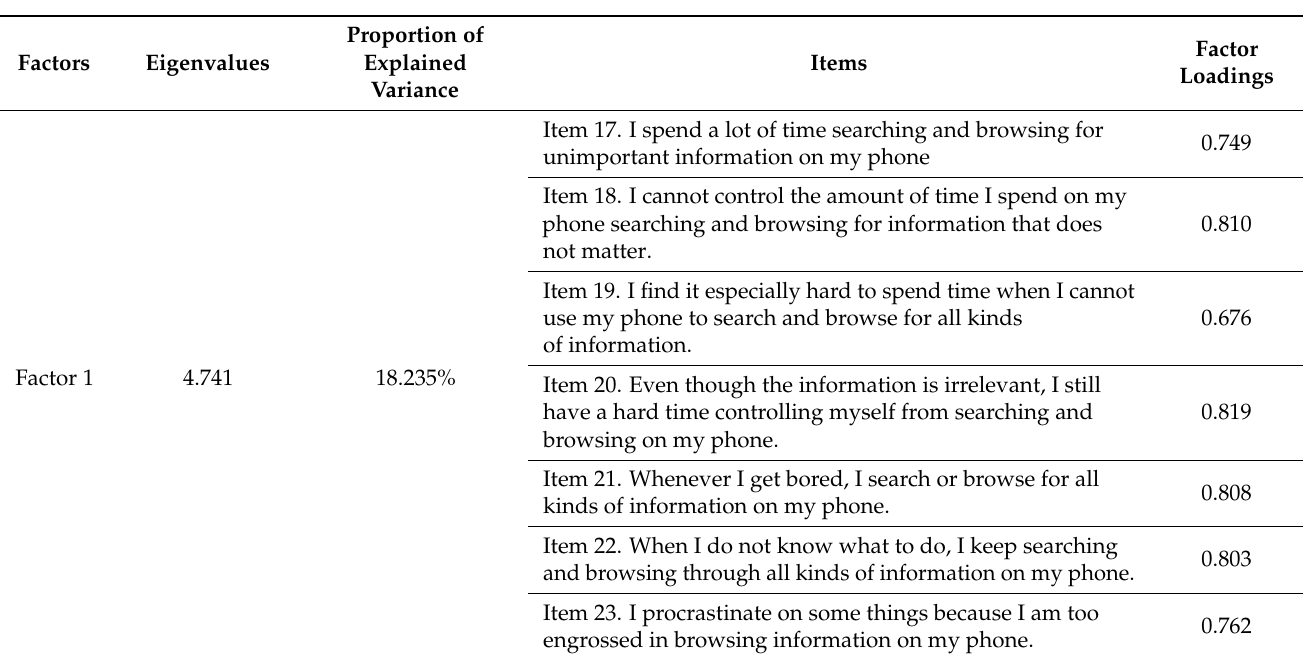
Table 2. Results of exploratory factor